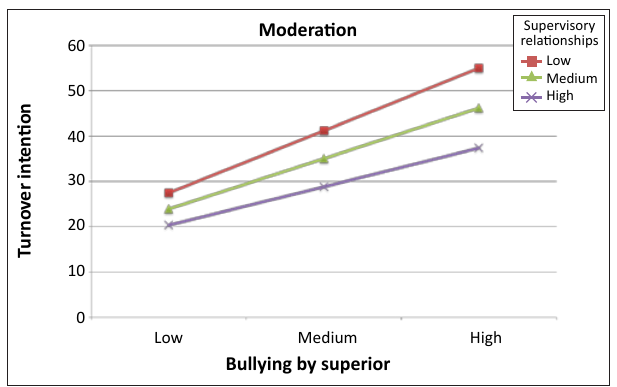
FIGURE 3: Interaction of bullying by superiors with supervisory relationships in relation to turnover